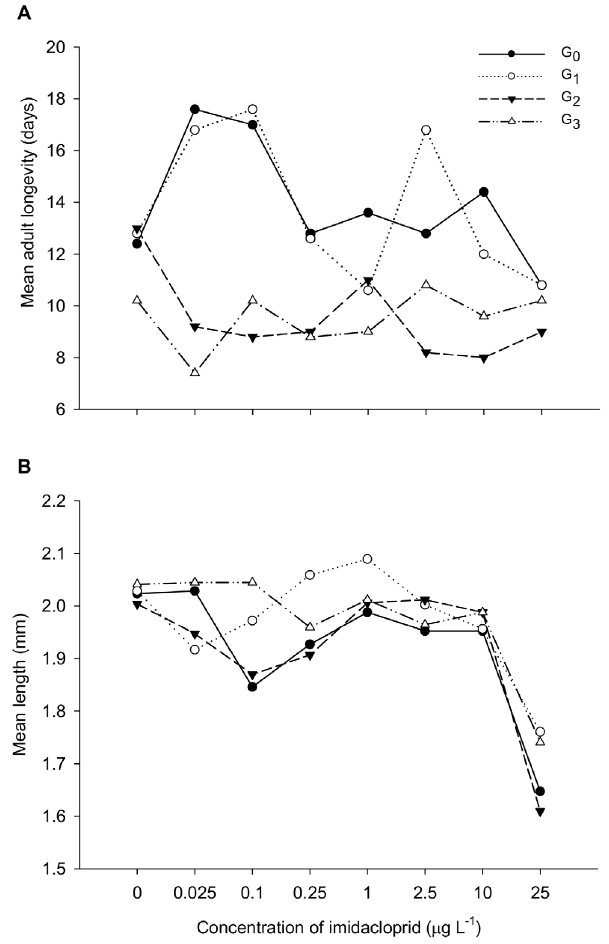
Figure 1. Multigenerational effects of low doses of imidaclo- prid on aphids. Multigenerational effects of continuous exposure to sublethal concentration of imidacloprid on the (A) longevity and (B) length of adult M. persicae.